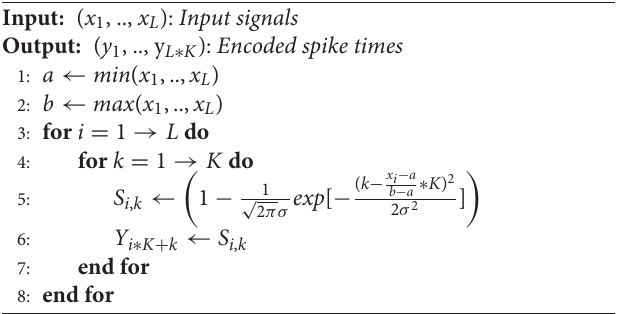
Algorithm 3 : Pseudocode for encoding the input